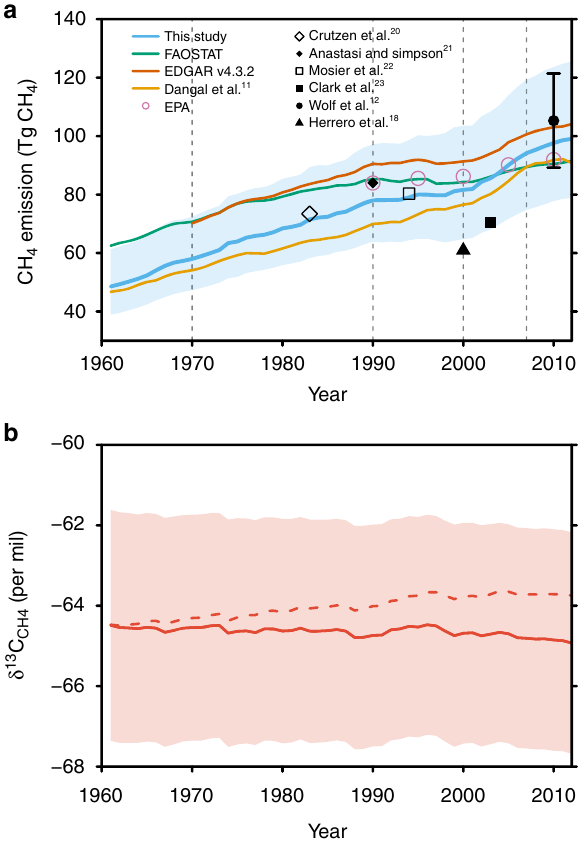
Fig. 3 The changes in the global methane emissions from enteric fermentation of ruminants ( F CH4-ruminant ), and their globally weighted average isotopic signatures δ 13 C CH4-ruminant over the period of 1961 – 2012. The blue ( a ) and red ( b ) shaded areas show the 95% con fi dence interval of the estimates of F CH4-ruminant and δ 13 C CH4-ruminant , respectively. The red dashed line in ( b ) shows the δ 13 C CH4-ruminant without accounting for the effect of δ 13 C CO2-atm trend (see Methods). The dashed gray lines in ( a ) separate the periods that we consider the trend of F CH4-ruminant in main text and Table 2. Source data are provided as a Source Data fi